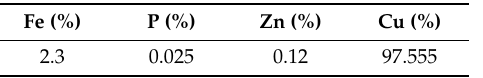
Table 1. Alloy’s composition.